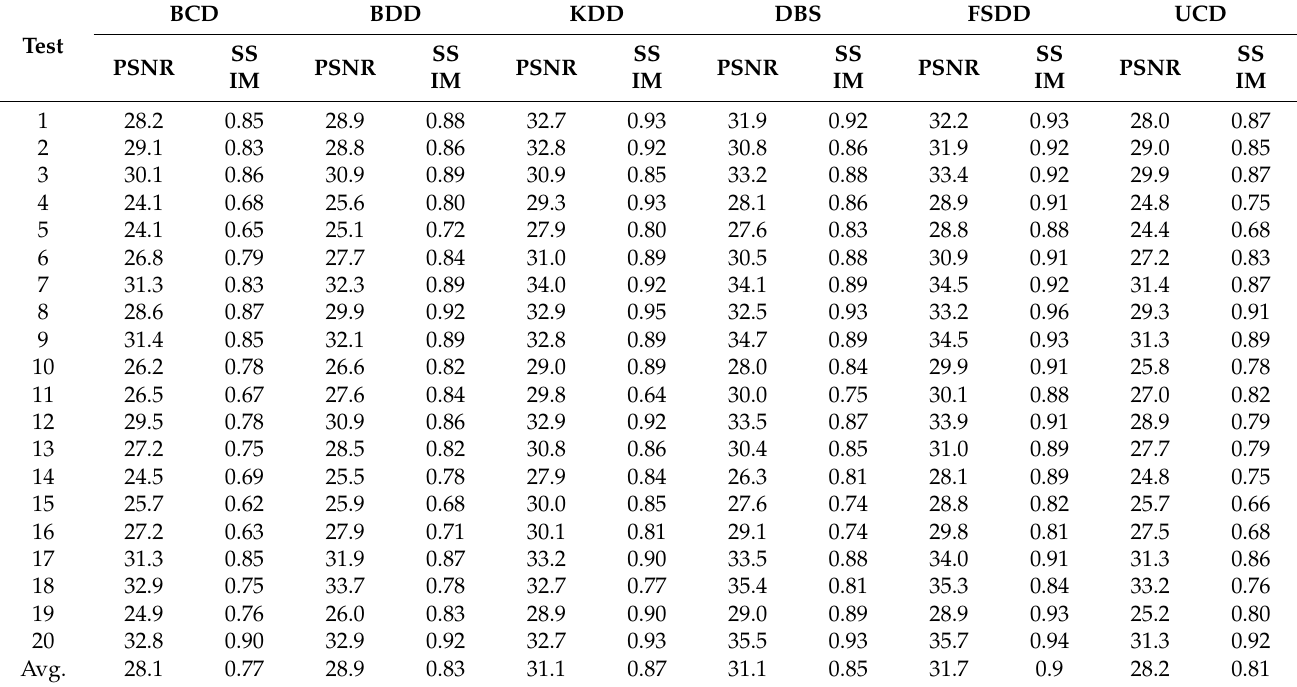
Table 3. Performance evaluation for different types of halftone